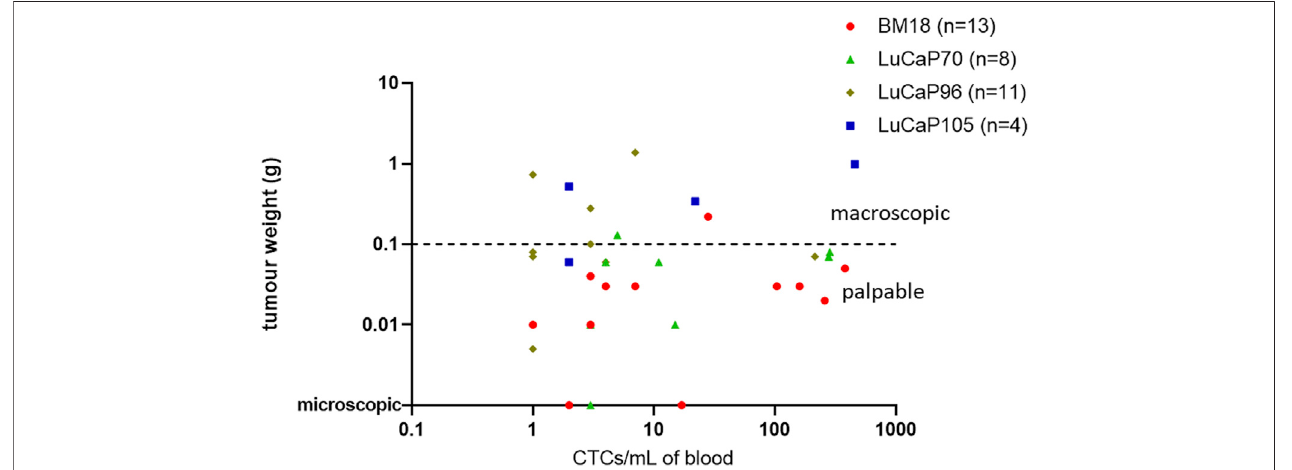
FIGURE5| Scatterplotcomparing endpointtumourweight (g)ofPDX-bearingcastratedmice totheestimatednumberofCTCsper mLinblood (based onmRNA levelsofRPL32).Eachpointdenotesanindividualmouse. Mosttumoursresponded tocastrationwithregression,including threemicehaving onlymicroscopictumours atendpoint( n =27/37).TheestimatednumberofCTCswasnotsigni fi cantlyrelated totumourweight usingnonparametricSpearman correlation anda95%con fi dence interval ( p = 0.50, r = 0.12). Note: One sample with unknown tumour weight at endpoint (LuCaP96) was omitted from this